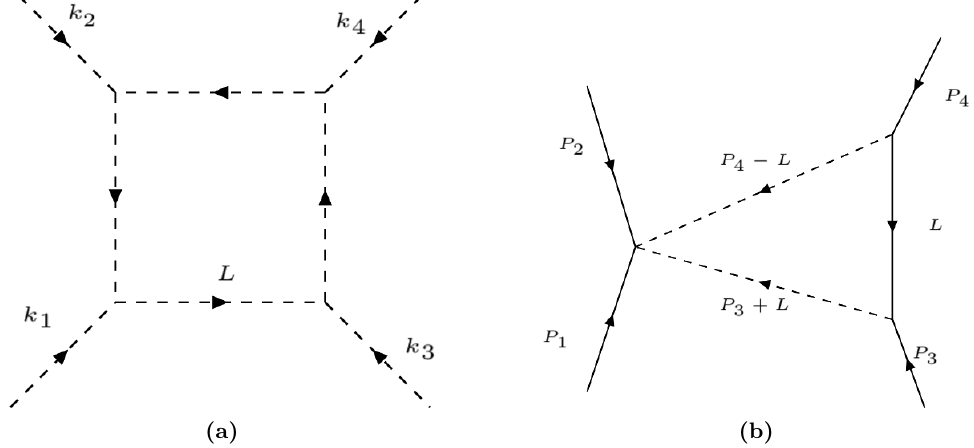
Figure 2. (a) Box with internal and external massless particles. (b) Triangle with massive external particles and massless internal particles. All lines in this work represent on-shell